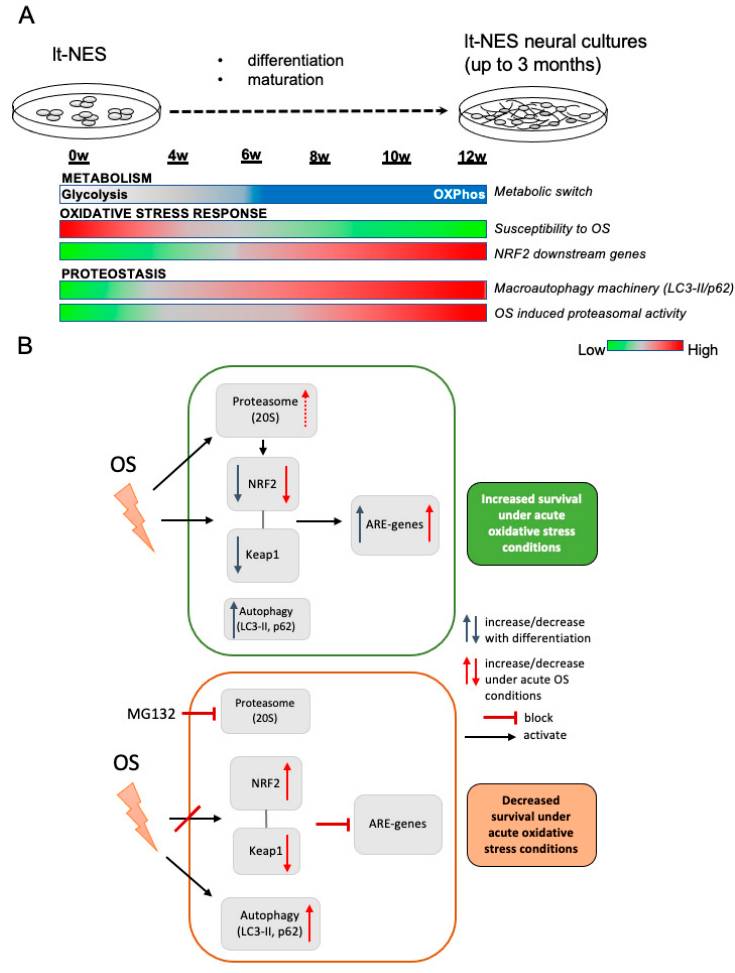
Figure 7. The oxidative stress response during neural differentiation is tightly coupled to developmental changes in proteostasis and NRF2-KEAP1 pathway modulation. ( A ) Schematic representation of alterations in OS-associated pathways across neural differentiation. ( B ) Schematic representation of the interaction between proteostasis (autophagy and proteasome) and the NRF2-KEAP1 pathway under physiological and acute OS conditions. Top panel: OS response control under functional proteostasis conditions. Bottom panel: OS response under dysfunctional proteostasis induced by proteasome inhibition.